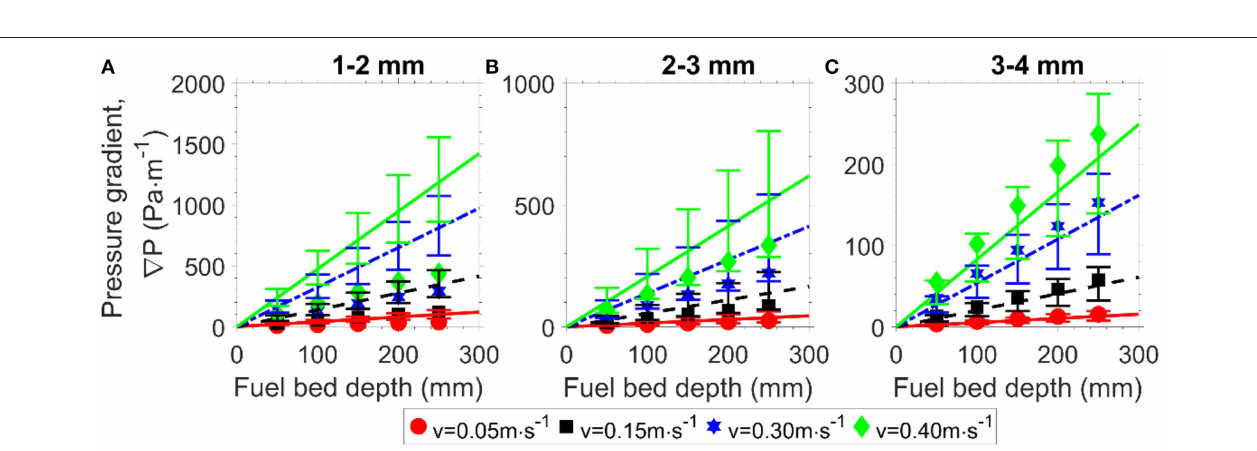
FIGURE 7 | Pressure gradient measured directly (markers) and calculated from the direct measured specific area (lines) as a function of fuel bed depth for pine chips over a range of air flow velocities. Error bars denote the calculated pressure drop based on the measure specific area through the Kozeny-Carman equation. Particle size ranges: (A) 1–2mm, (B) 2–3mm, (C)